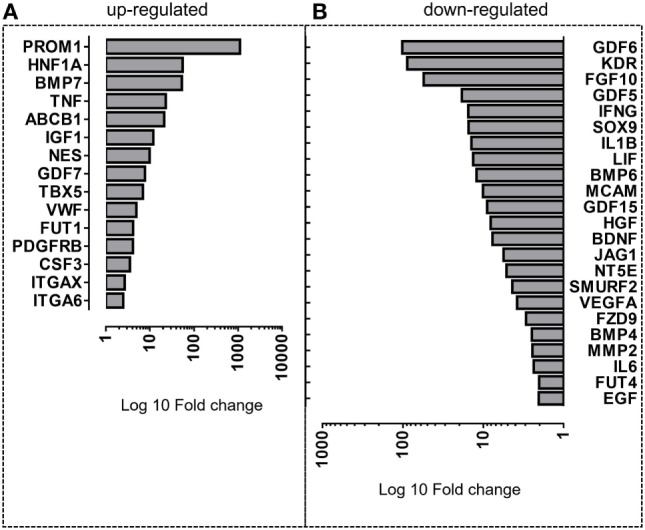
Differentially expressed genes in Polyp-MSCs (PO-MSCs) in comparison with bone marrow-derived MSCs (BM-MSCs). Bar plot representing the most upmodulated (A) and downmodulated (B) genes in the comparison of PO-MSC versus BM-MSC. A differential gene expression profile is observed between PO-MSCs and BM-MSCs, suggesting a distinct transcriptional background for these cell populations.